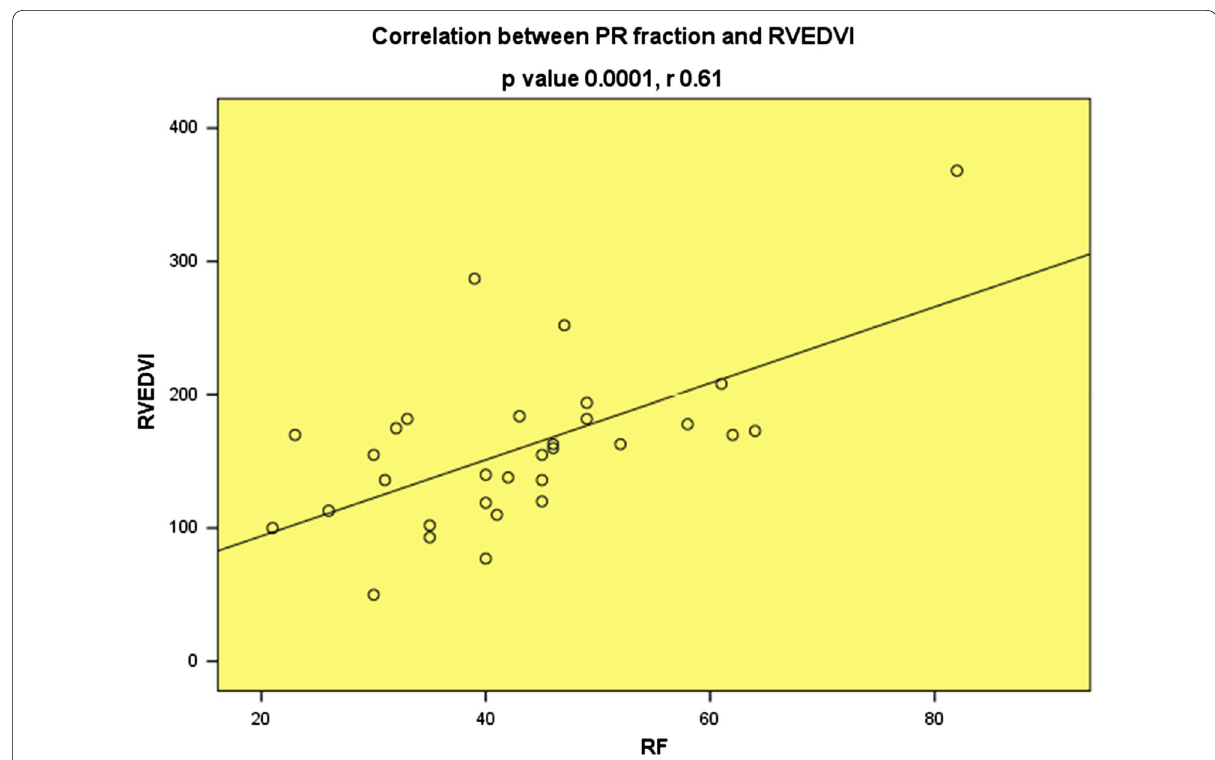
Fig. 4 Correlation between RF and RVEDVI